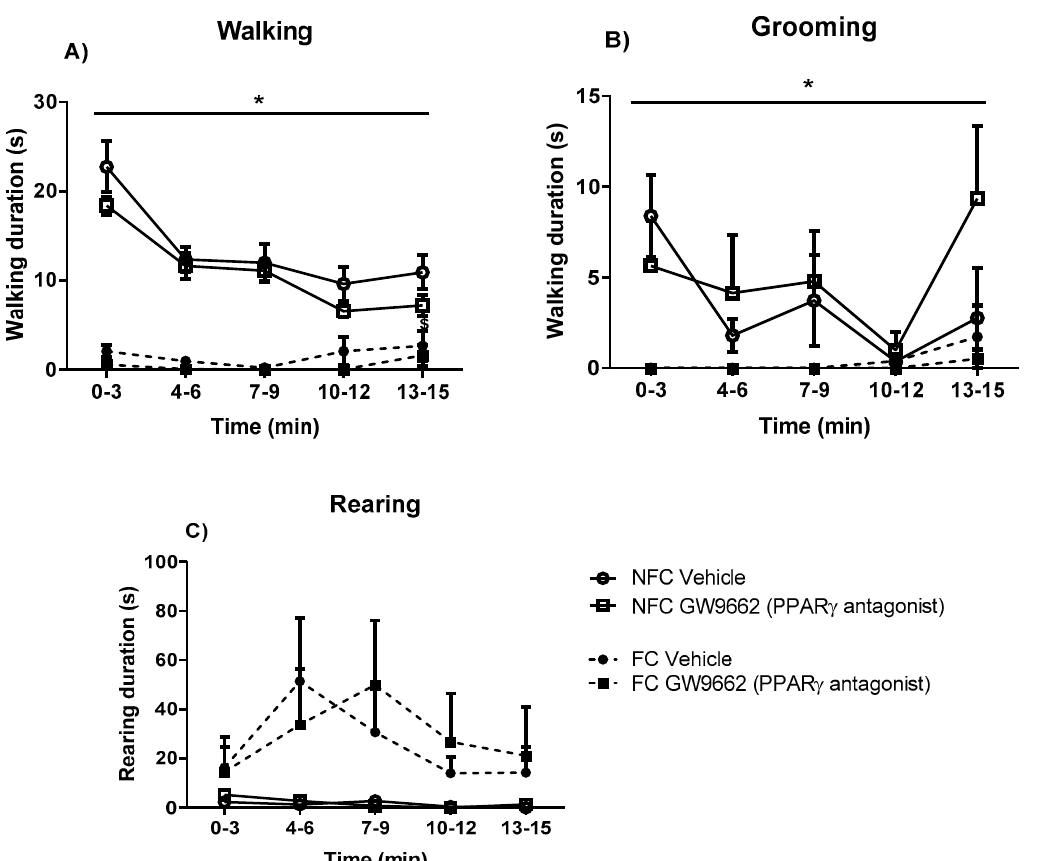
Figure 8. E ff ects of fear-conditioning and systemic administration of selective PPAR γ antagonist on walking duration ( A ), grooming duration ( B ), and rearing duration ( C ). Data (mean ± S.E.M) is represented in 3-min time bins ( n = nine rats per group). According to a repeated measured ANOVA ( p < 0.05), * significant overall e ff ect of fear conditioning.